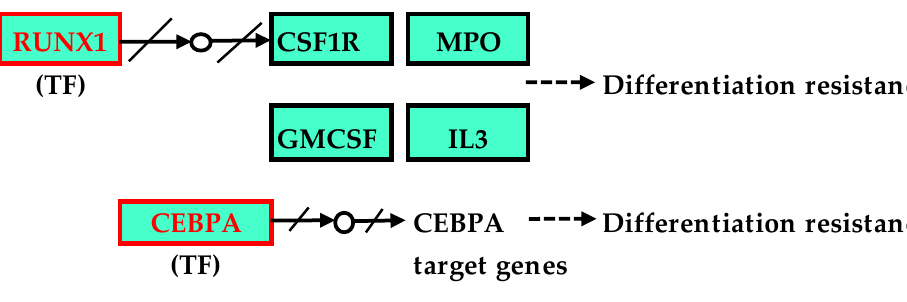
Figure 6. Transcriptional misregulation pathway and pathways in cancer (reference: KEGG path- ways) [12,48]. This pathway illustrates the affected hub-gene RUNX1 and the upstream gene, CEBPA, in red boxes, which elucidates the differentiation resistance in AML-NK patients in this cohort in cases with deregulated CEBPA and RUNX1 genes. Upregulation of the RUNX1 and CEBPA genes could lead to impaired resistance to normal haematopoietic differentiation.